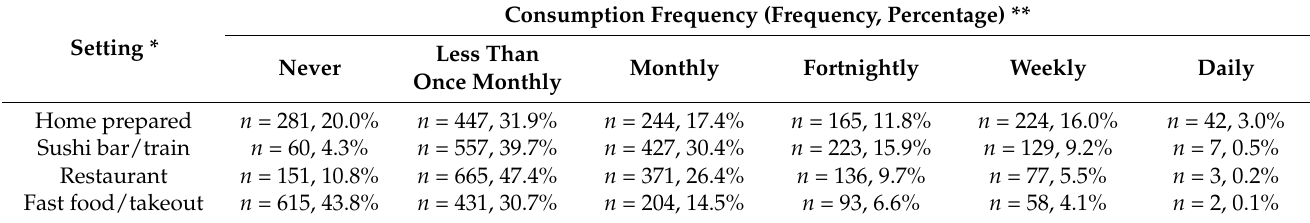
Table 3. Frequency of seaweed consumption at different settings ( n =